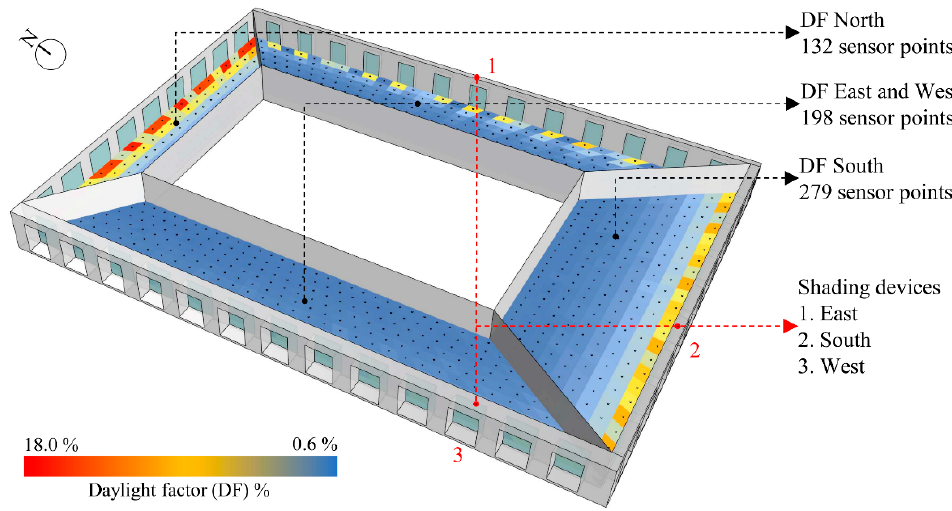
Figure 8. Simulation result of DF for one design alternative in one floor level.